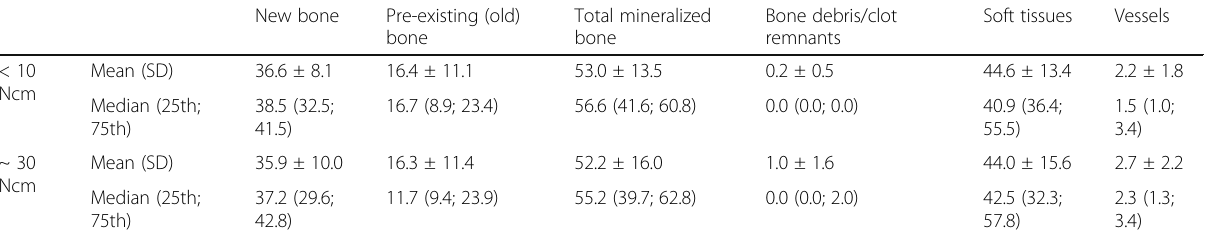
Table 3 Percentages of tissues around the implant surface after 8 weeks of healing. Mean percentages ± standard deviations (SD), medians, and 25th and 75th percentiles (25th; 75th) of tissues around the implant surface ( n =